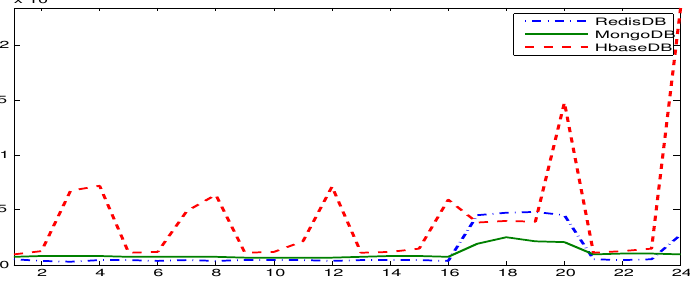
Figure 18. (F) Read/Read-Update ratio: 50/50.